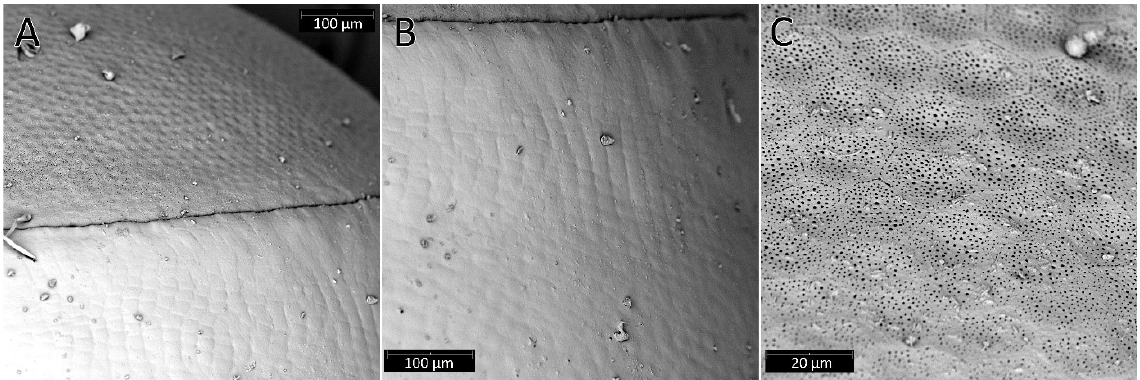
Figure 2. ( A ) The groove between the chorial and opercular borders Psyttala horrida (Stål, 1865); ( B ) The exochorion with irregular follicular imprints near the opercular region; ( C ) The numerous orifices in the polygonal ornamentation of the operculum.